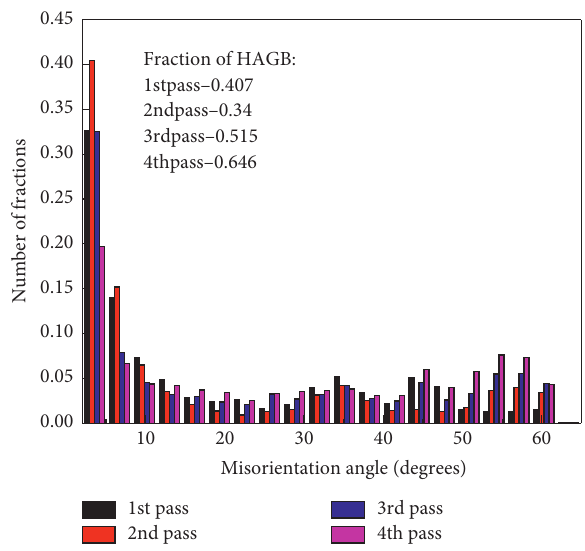
Figure 8: Distributions of misorientation angles of the aluminum in the Al-Nb/Ti/Ni